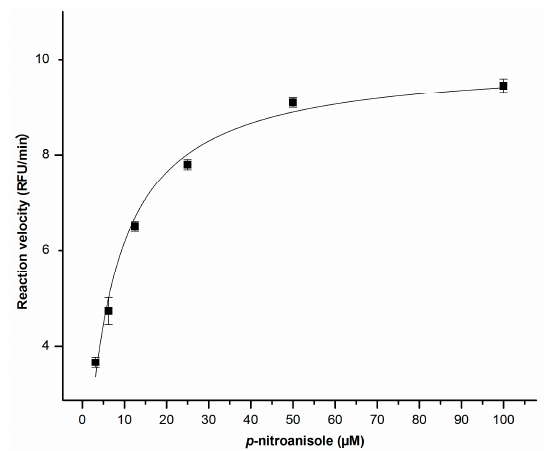
Figure 2. The metabolic activity of the recombinant CYP353D1v2 enzyme. Rate of dealkylation reaction of recombinant CYP353D1v2 with the fluorescent substrate p -nitroanisole. The Km value was determined as 6.21 ± 0.65 µM.